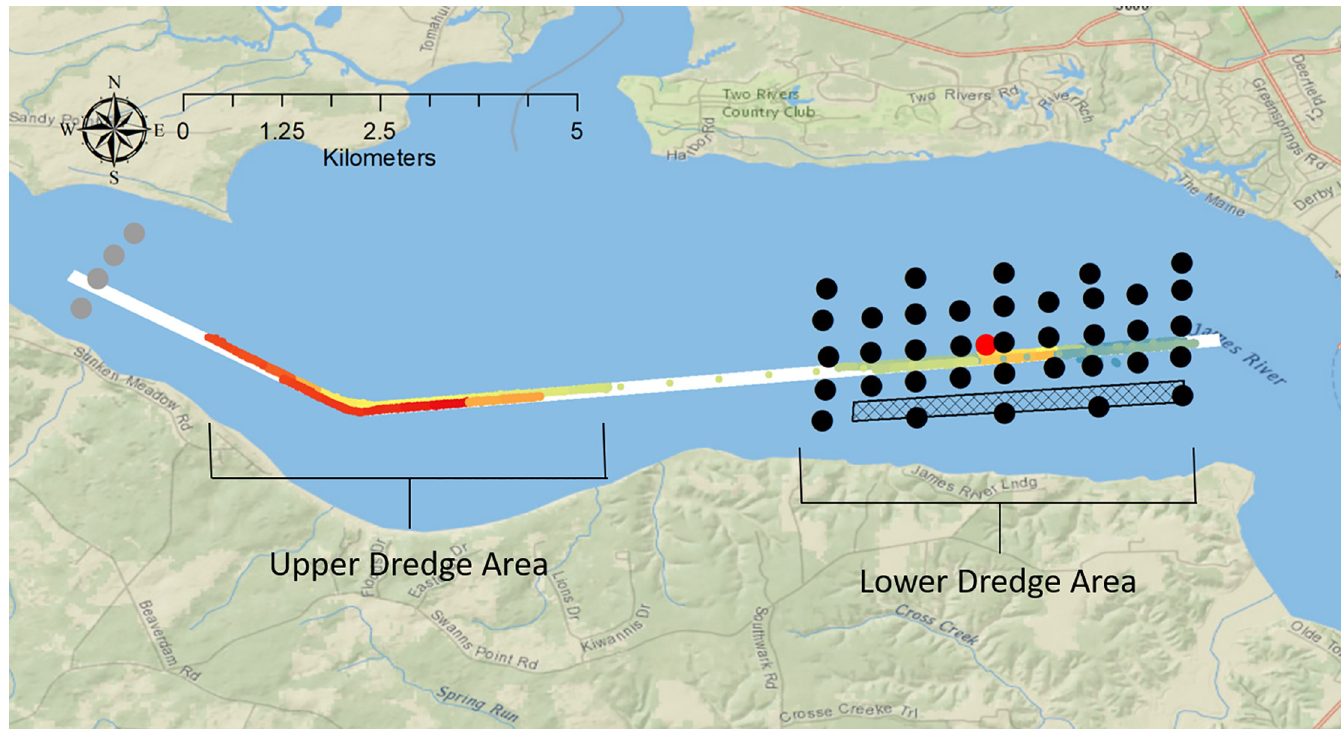
Fig 2. Map of study design. The white polygon is the navigation channel and the colored dots within the channel are where the hydraulic-cutterhead dredge was working during the study period. The colored dots within the channel show where the dredge was working. The different colors show where the dredge was working each day. The black dots are collocated receiver locations of the Vemco Positioning System array. The red dot is a reference tag to assist with determining fine-scale positions for the telemetered Atlantic sturgeon. The gray dots are receiver locations for the supplemental array upstream of the dredge area. The black grid in the southern area of the array is where the dredged material from the lower dredge area was placed. Basemap reprinted from Ocean Basemap under a CC BY license, with permission from ESRI, original copyright 2012.